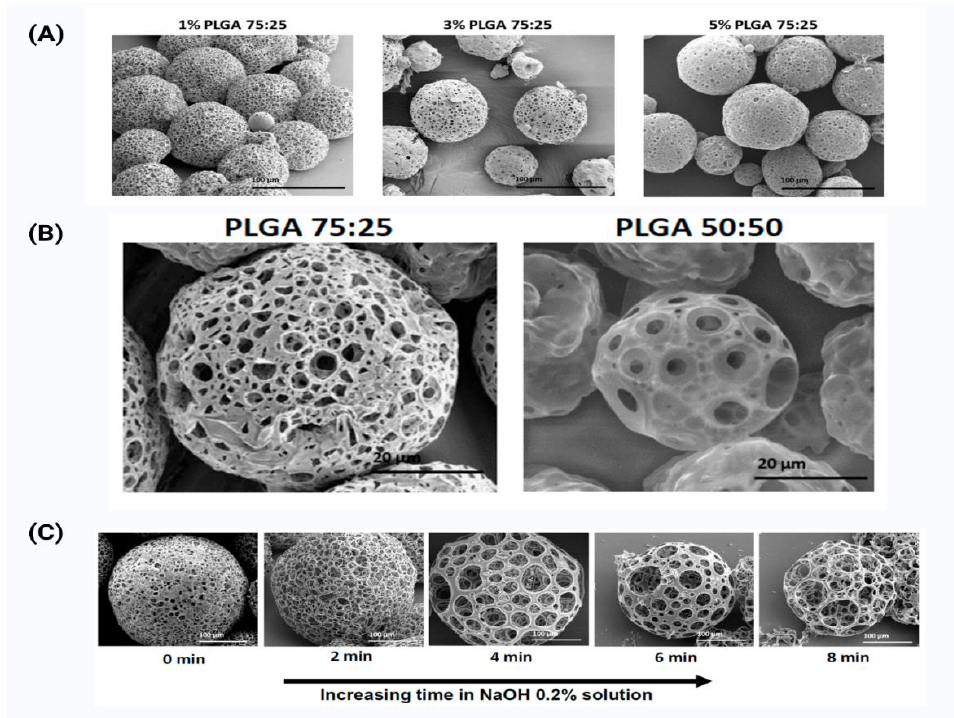
Figure 3. The figure shows different scanning electron microscope (SEM) images of poly(lactic-acid (PLGA) materials. ( A ) PLGA porous microsphere made by batch synthesis with increasing PLGA 75:25 concentrations (% w/v ), 1%, 3%, and 5%. ( B ) SEM images representing the morphology of porous and non-porous microspheres obtained with PLGA polymers and MWT using PLGA 75:25, PLGA 50:50. ( C ) SEM images of 3% ( w/v ) PLGA 75:25 porous microspheres taken by the microfluidic technique at increasing soaking time in NaOH 0.2% solution. As immersion time increased, a more porous structure was obtained. This figure is adapted from [30].